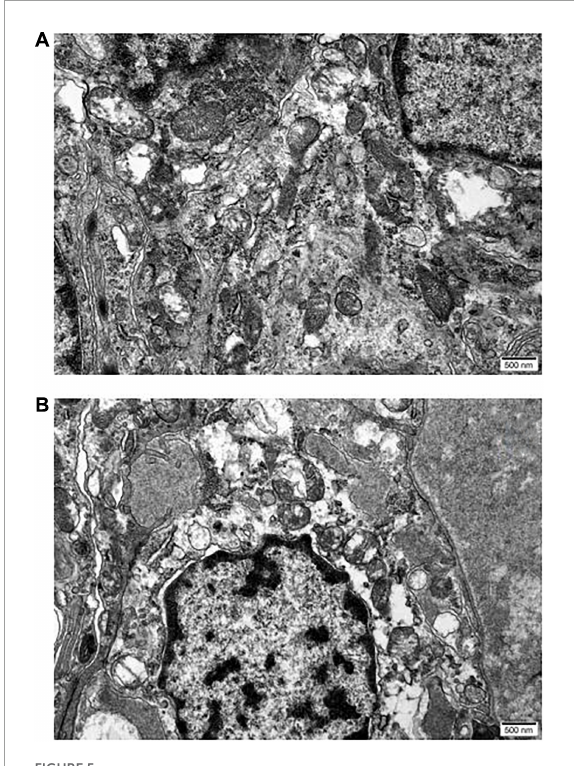
FIGURE5 Micrographs reveal the differences between epithelia of normal ciliary body (A) and UCP postoperative (B) . Scale bars 500